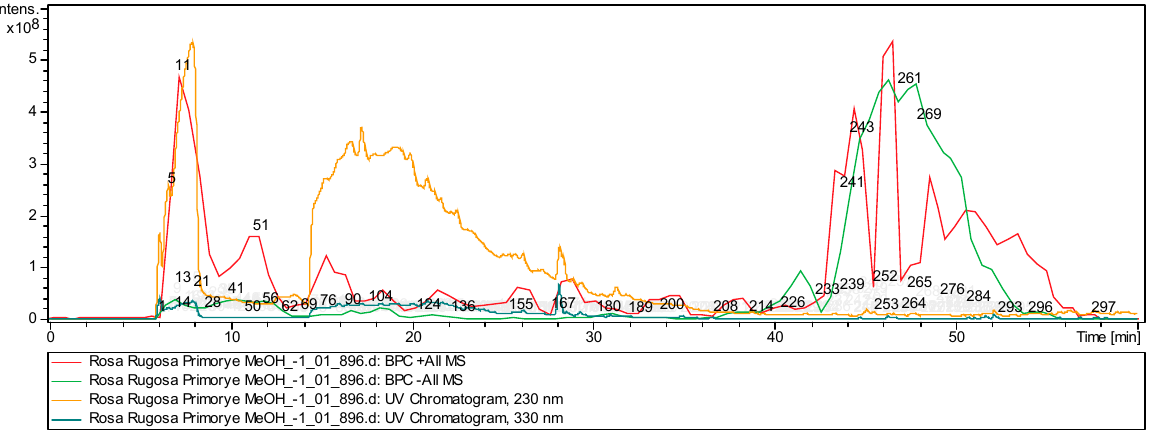
Figure 3. Representative chemical profiles of the R. rugosa (Primorye, Russia) total ion chromatogram from the MeOH